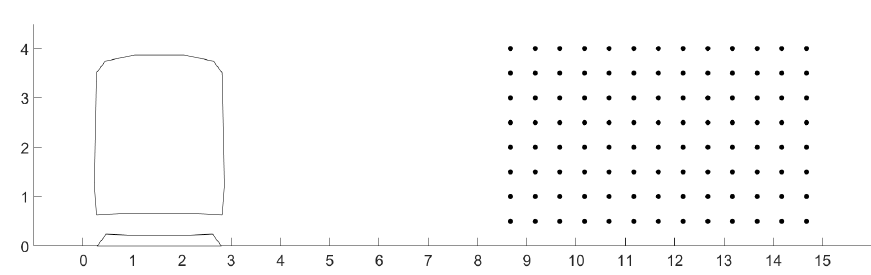
Figure 14. Representation of the receiver mesh used in the